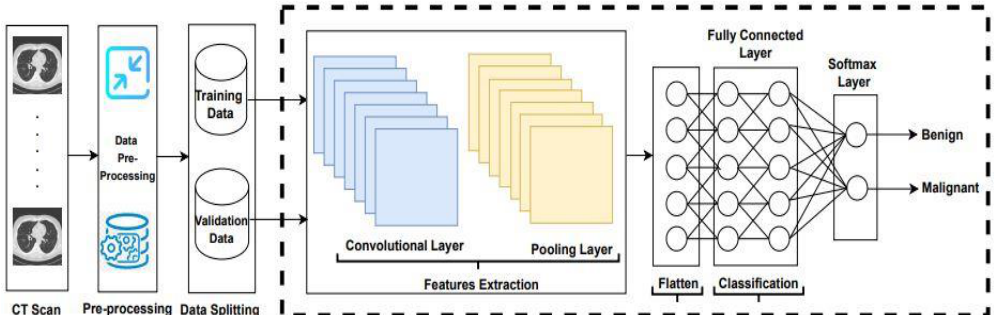
Figure 1. Convolutional neural network architecture.